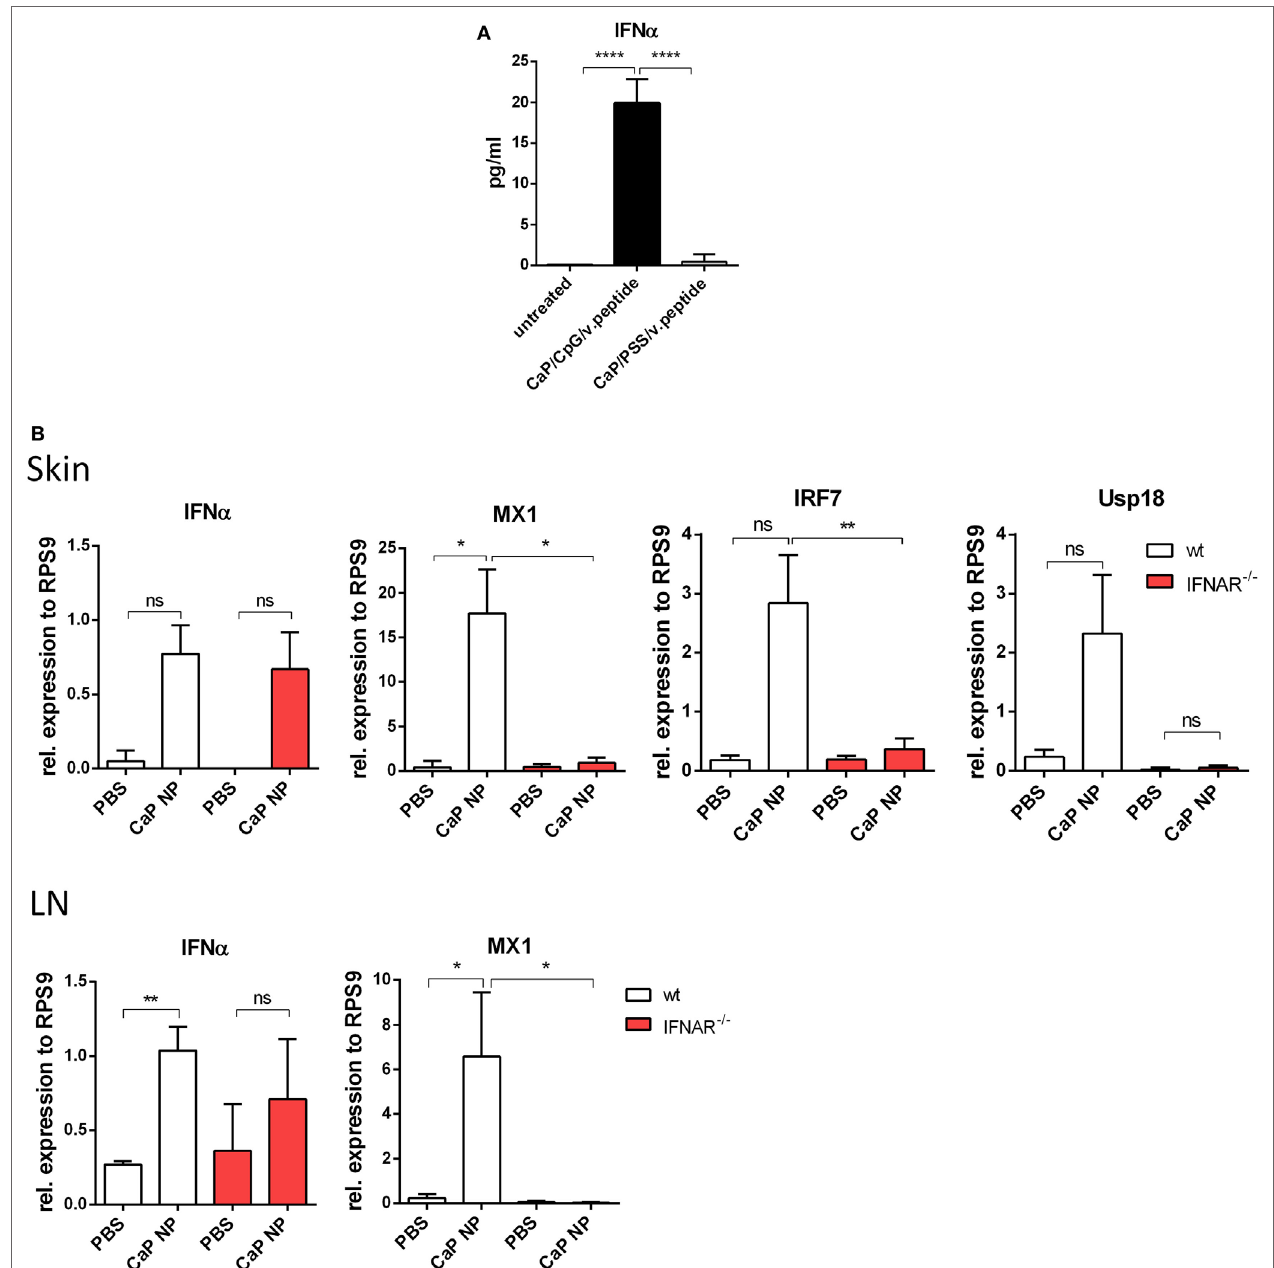
FigUre 1 | Induction of type I interferon (IFN I) signaling by CpG functionalized calcium phosphate (CaP) nanoparticles (NPs). (a) CD11c + cells were isolated from the spleen and incubated with CpG functionalized CaP NPs or CaP NPs functionalized with non-immunogenic polystyrene sulfonate. Concentrations of IFN α in cell culture supernatants were analyzed 4 h later by Luminex technology, n = 6. Statistical analysis was performed by ANOVA with Bonferroni’s multiple comparisons test (**** p < 0.0001). (B) Expression of IFN α and the interferon regulated genes (IRF) MX1, IRF7, and Usp18 were analyzed by quantitative real-time PCR in the skin and the popliteal lymph node 5 h postvaccination, n = 6. The results of two independent experiments are shown. Bars represent mean ± SEM. Statistical analysis was performed by Student’s t -test (* p < 0.05; ** p <